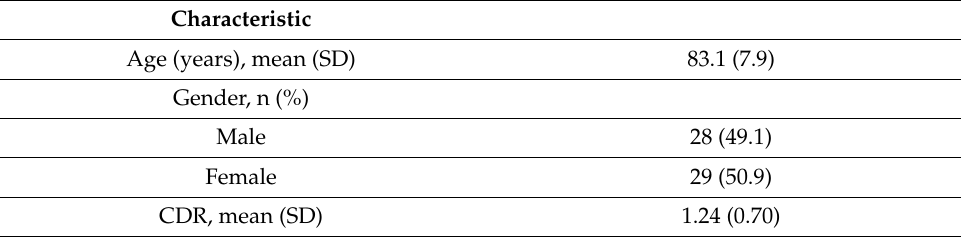
Table 1. Clinical characteristics of participants (n =